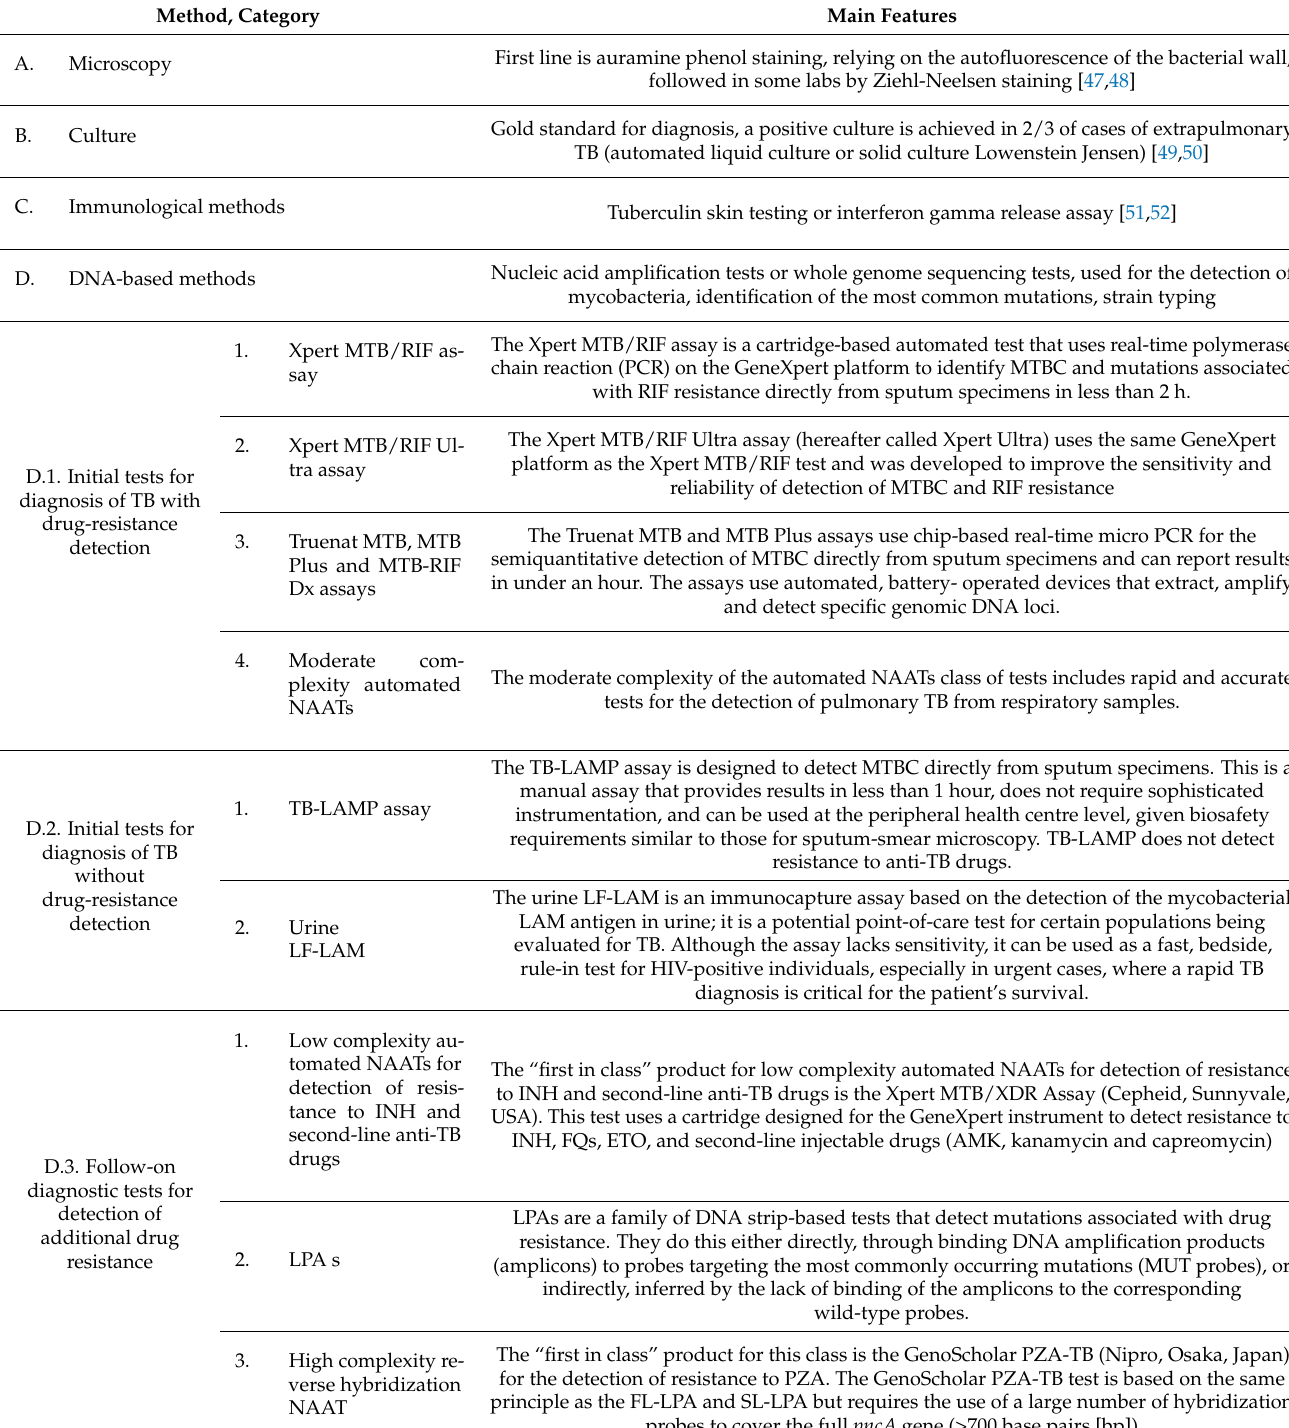
Table 7. Diagnostic methods in tuberculosis, as per WHO consolidated guidelines on tuberculosis, Module 3: Diagnosis [46]. Method,